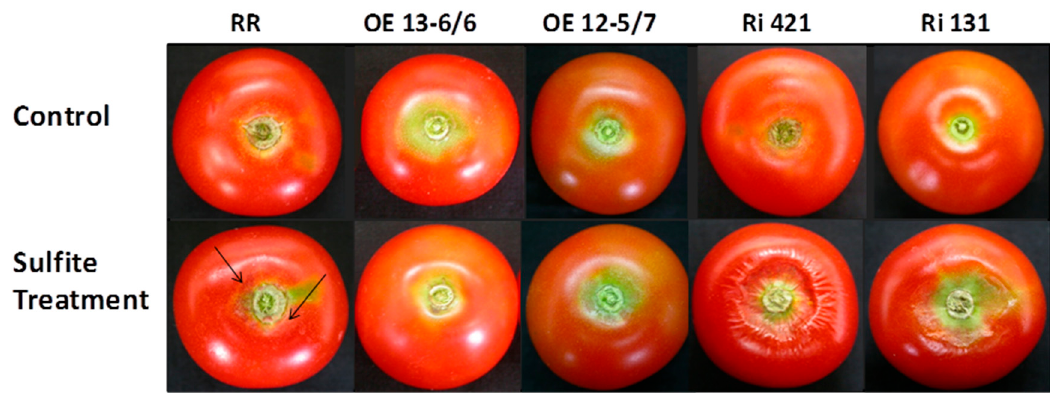
Figure 10. Effect of sulfite dipping on the fruits of wild type and SO modified plant’s appearance. Fruits of wild type (RR), SO OE (OE 13-6/6 and OE 12-5/7), and SO Ri (Ri 421 and Ri 131) lines were dipped for two hours in 200 mM Na 2 SO 3 , subsequently kept at room temperature for 24 h and photographed. The damaged regions are indicated by arrows in the sulfite treated RR fruit. Fruits dipped in water served as a control.